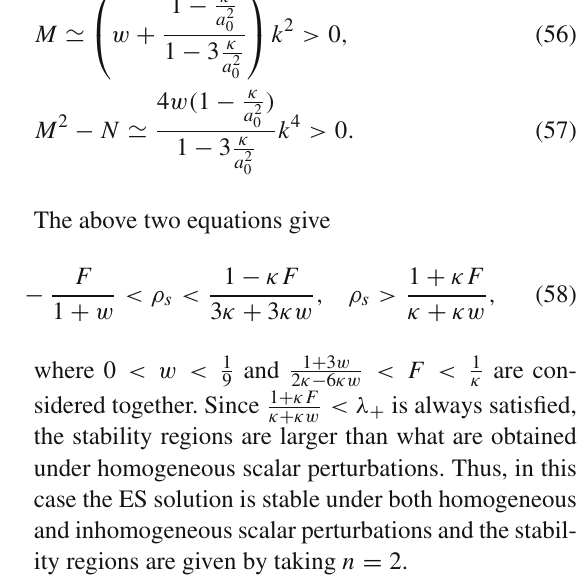
, while the right one for ρ s = 15 and 3